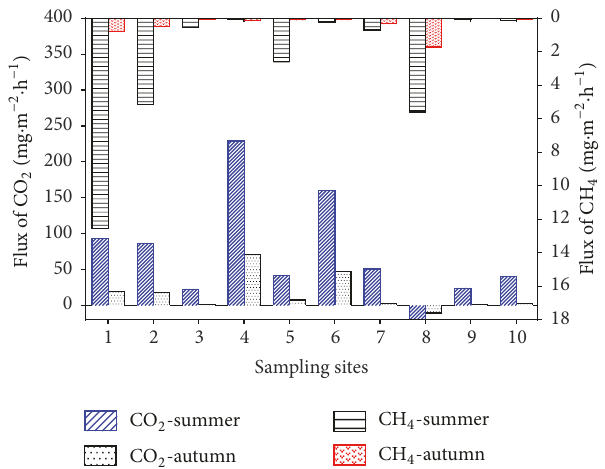
Figure 2: The flux of CO 2 and CH 4 in summer and autumn in various